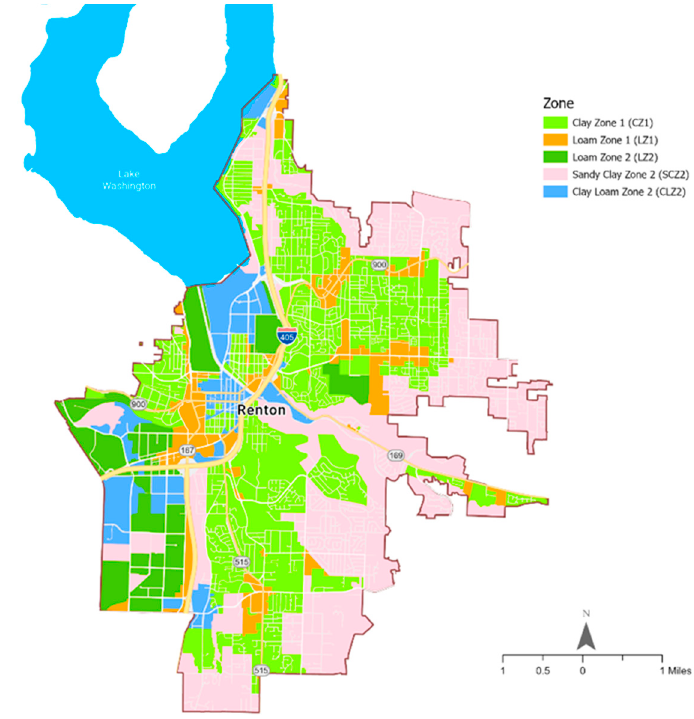
Figure 4 . Soil zones used to determine the suitability of locations for a given LID. Figure 4. Soil zones used to determine the suitability of locations for a given